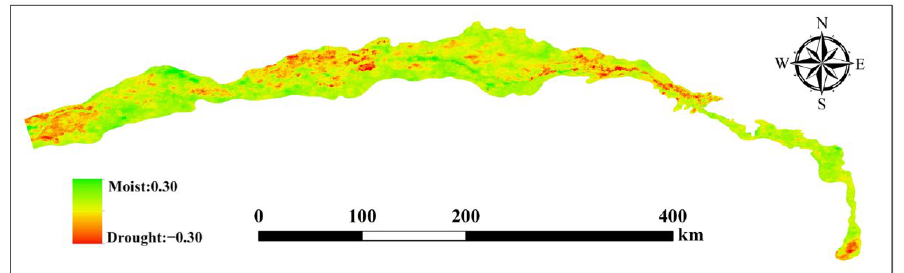
Figure 5. Spatial variation distribution of TVDI in the mainstream area of the Tarim River from 2015 to 2021.